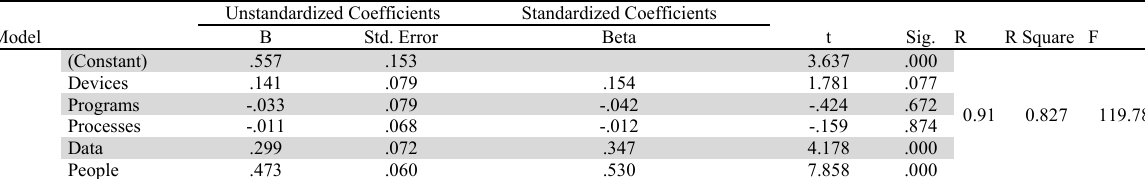
H: MIS components positively influence e-marketing strategies. The results of testing the main hypothesis Model